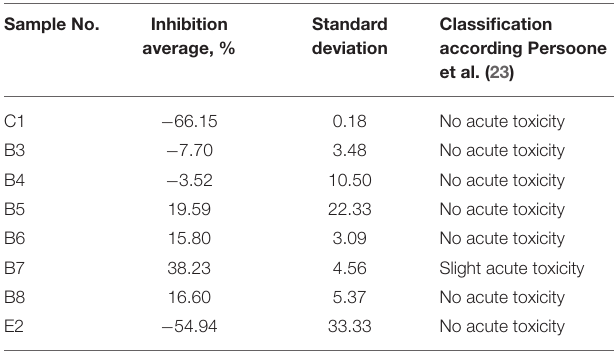
TABLE 2 | Inhibition of A. fischeri luminescence caused by undiluted sediment elutriates corresponding to 75mg sediment dry weight/ml, after 1min incubation. Sample